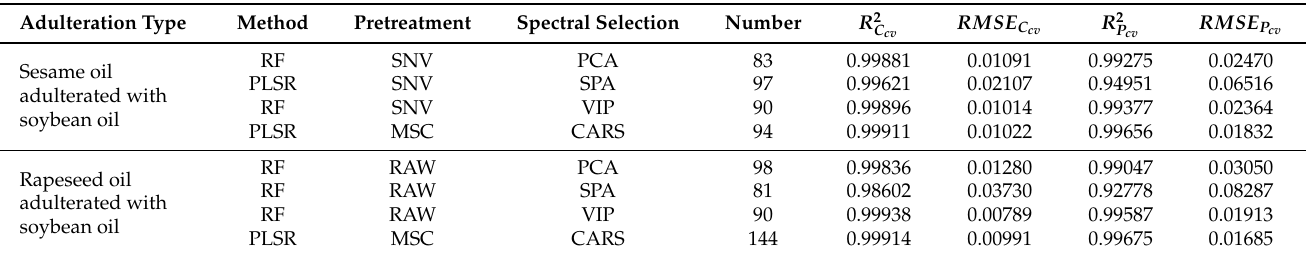
Table 4. Prediction results obtained by the better model using effective